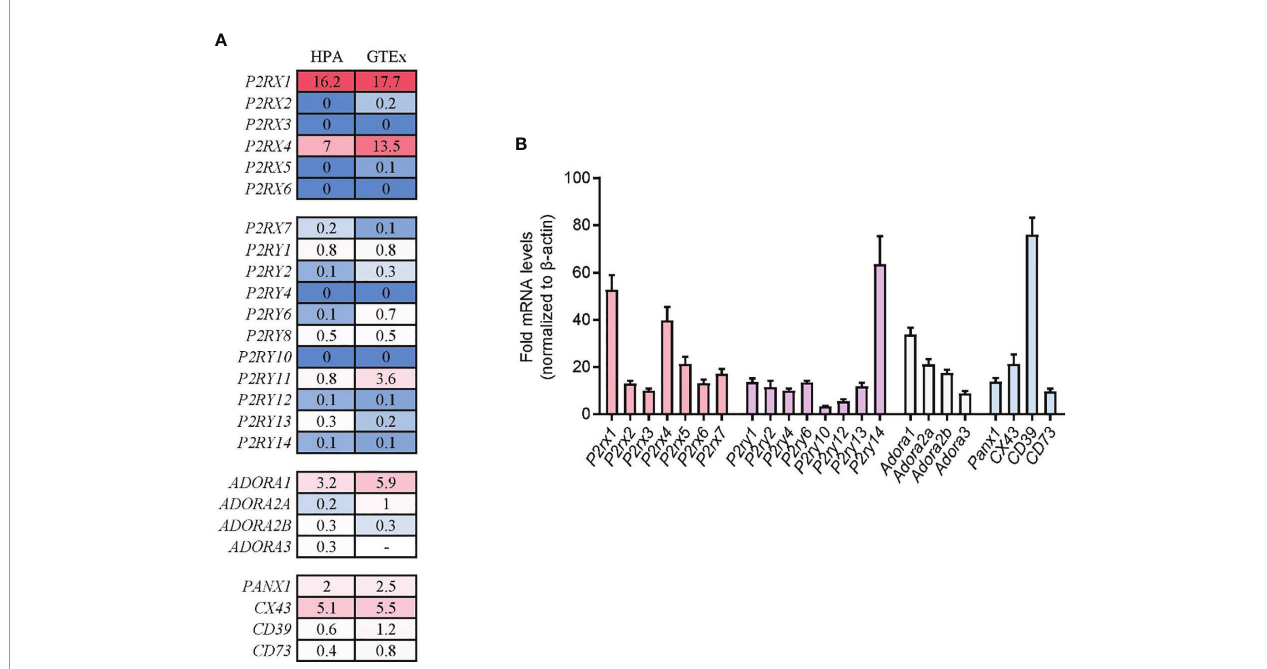
FIGURE 1 | Expression pro fi les of purinergic signaling molecules in human and mouse pancreas tissue. (A) Purinergic signaling molecule expression in human pancreas tissues was analyzed in Human Protein Atlas (HPA) and Genotype-Tissue Expression (GTEx) human tissue RNA sequencing (RNA-seq) databases. Values were presented as protein-coding transcripts per million (pTPM). (B) Purinergic signaling molecules expression in mouse pancreas tissues was determined by RT- qPCR and normalized to b -actin (n = 4 per